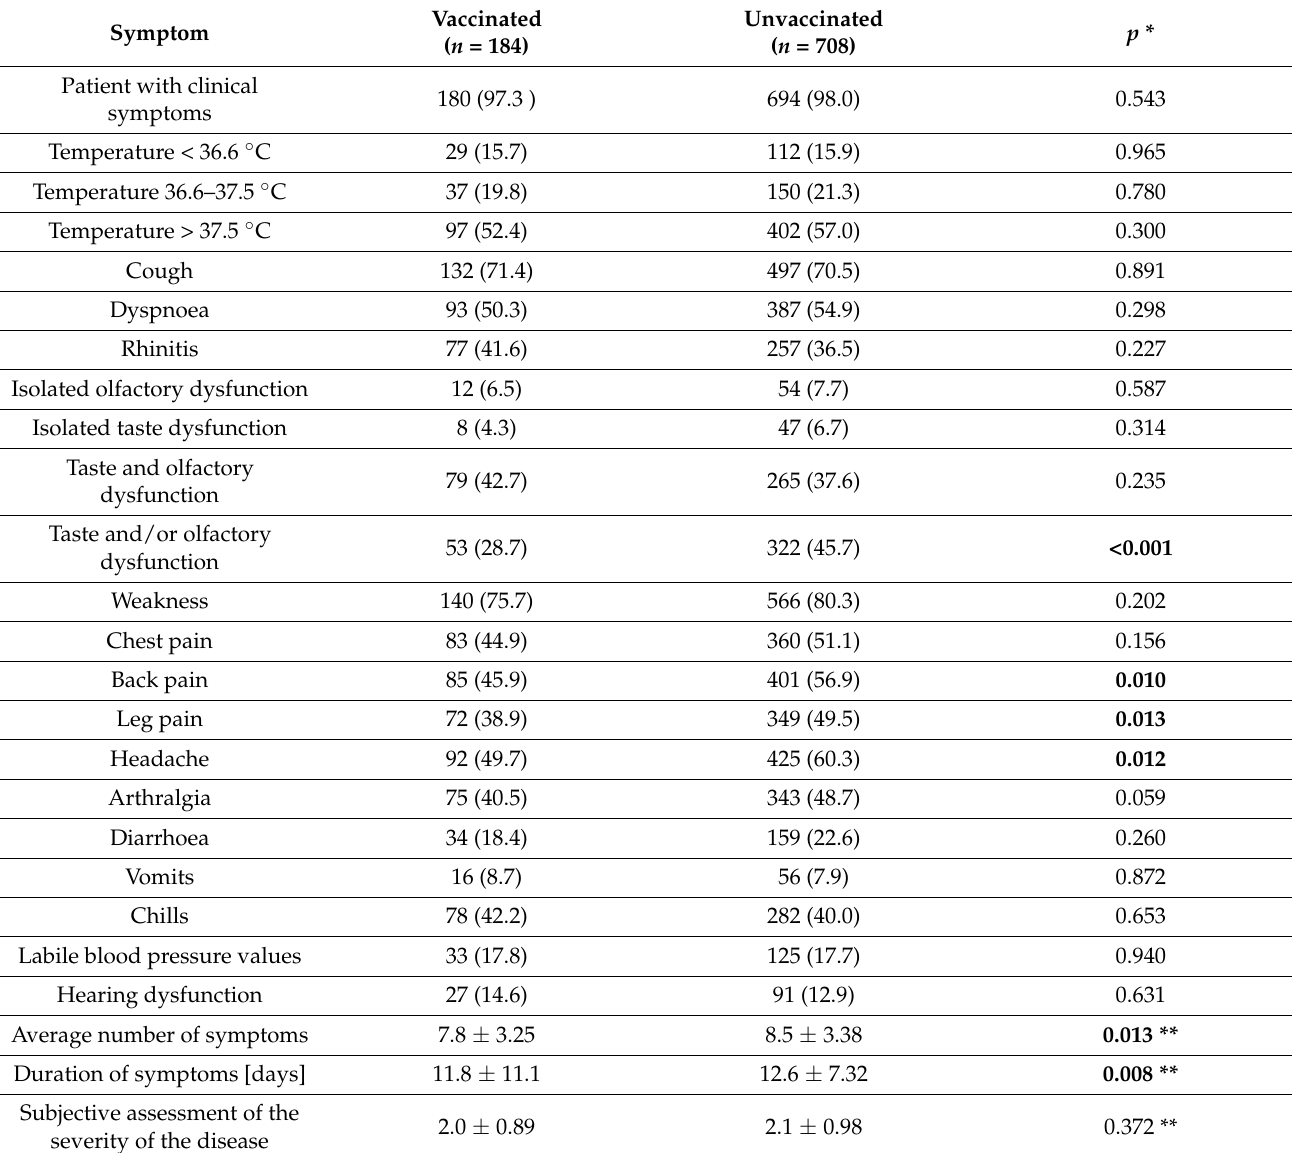
Table 4. Comparison of the clinical picture between vaccinated and unvaccinated patient in second and third